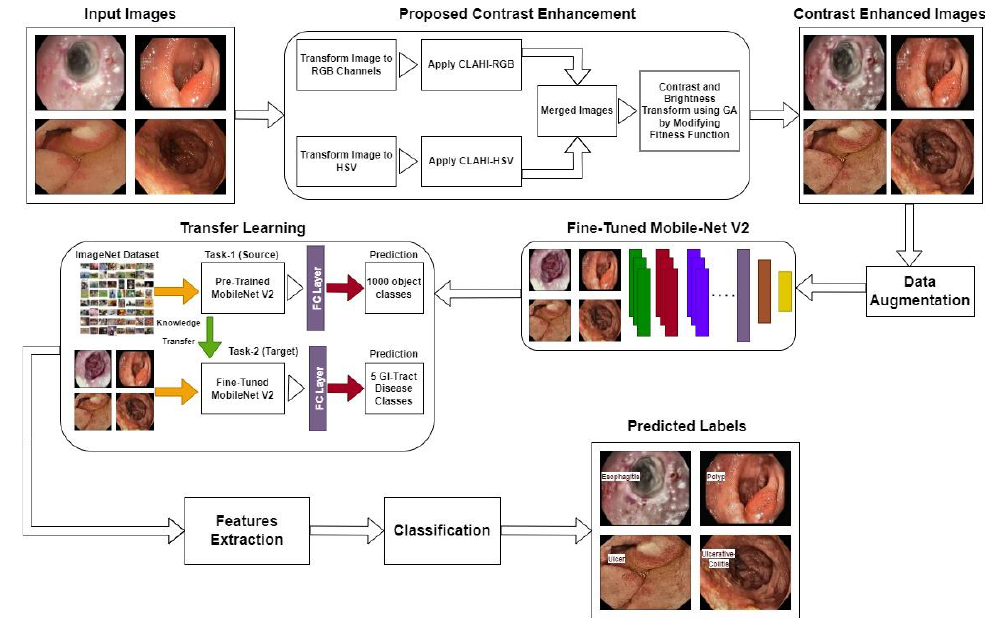
Figure 1. Proposed